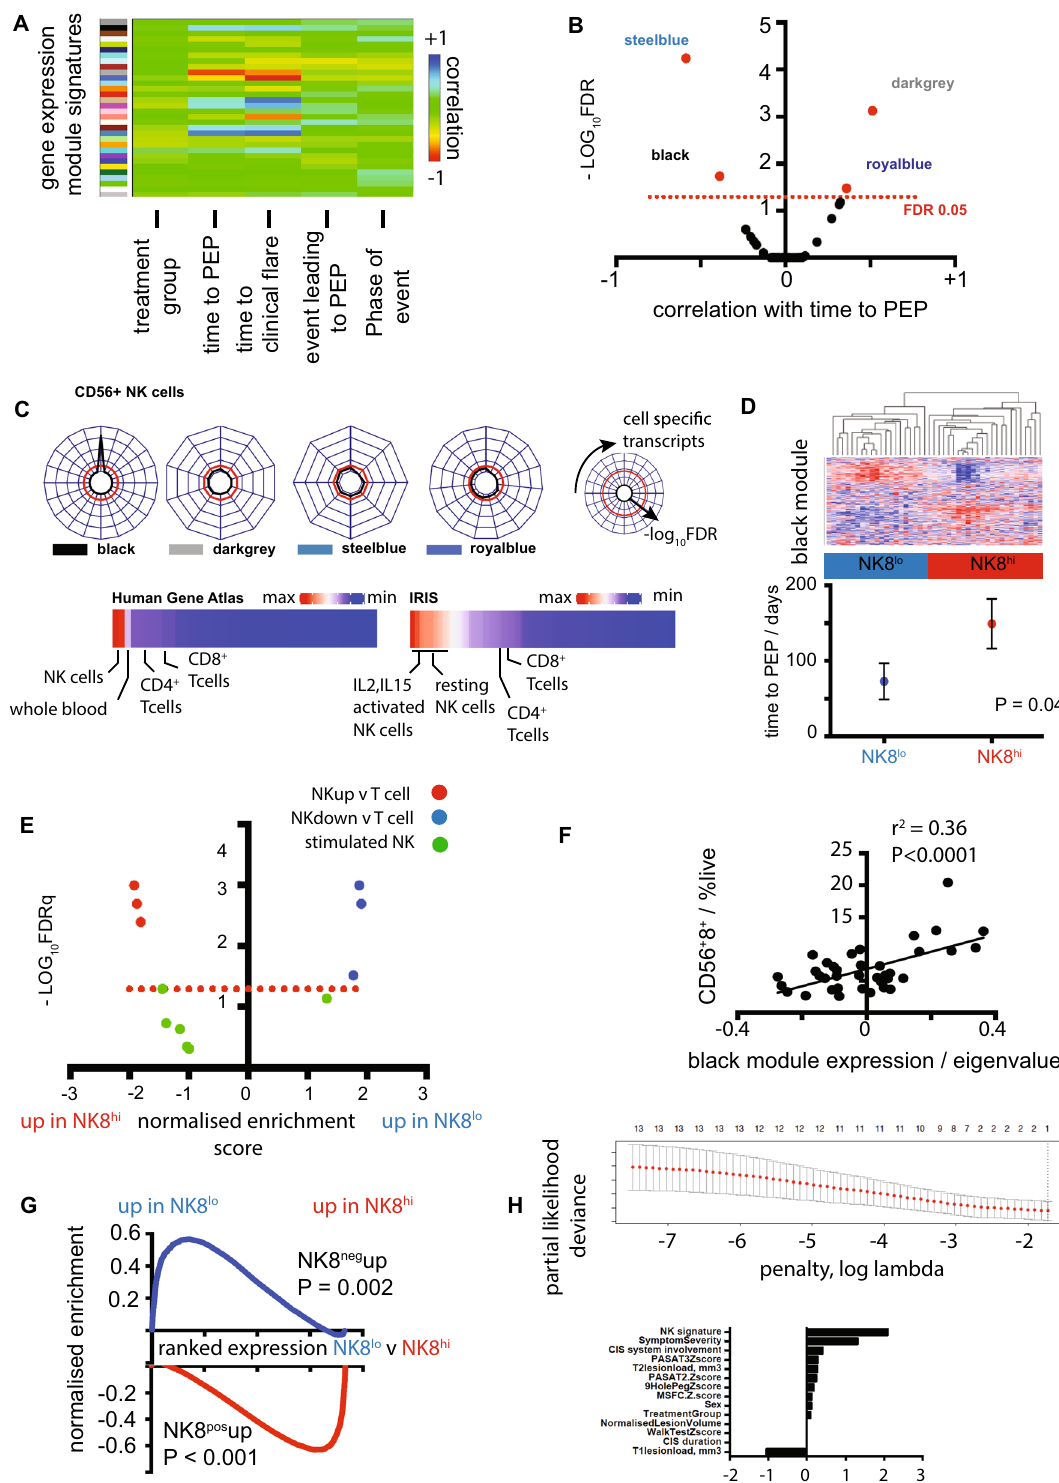
inhibitory signals might explain the superior ability of NK8 + cells the activating receptor NKG2D, and reduced expression of two to inhibit autologous CD4 + T cell activation. Using a validated fl ow cytometry panel 22 we quanti fi ed the expression of NK killer inhibitory and activating receptors (Supplementary Data 4) on NK8 + , NK8 − and CD56 hi subsets in PBMC from healthy indi- viduals. While most receptors were equivalently expressed (Sup- plementary Fig. 6), we observed increased expression on NK8 + of NATURE COMMUNICATIONS| (2021) 12:635